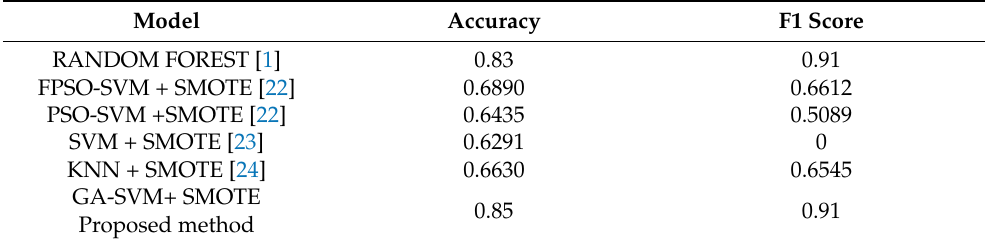
Table 2. Comparison of existing approaches with respect to Accuracy and F1 Figure 4. Summary of the accuracy score curve with balanced weights.